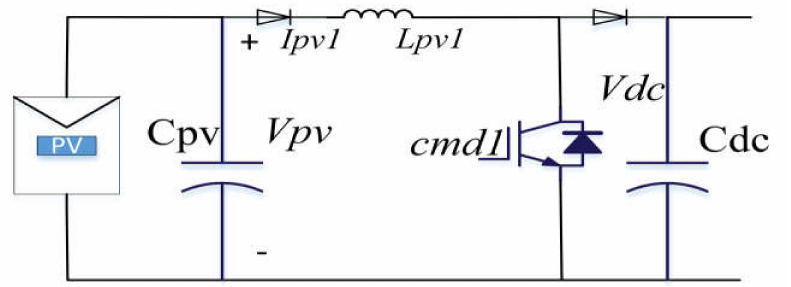
Figure 6. DC boost converter model.